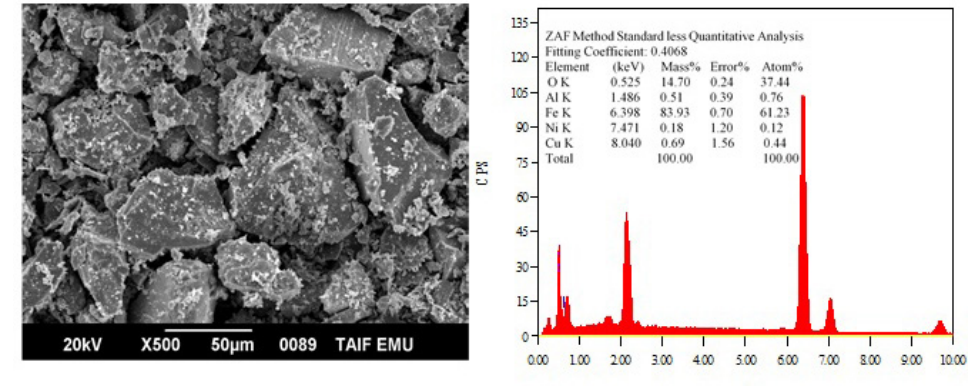
Figure 4. SEM image and correspondent “EDS” spectrum analysis of Hot-Rolled mill scale.